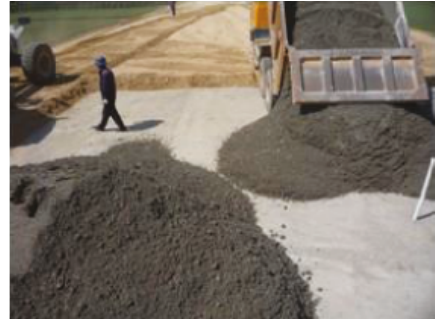
Figure 20: Roller compaction.